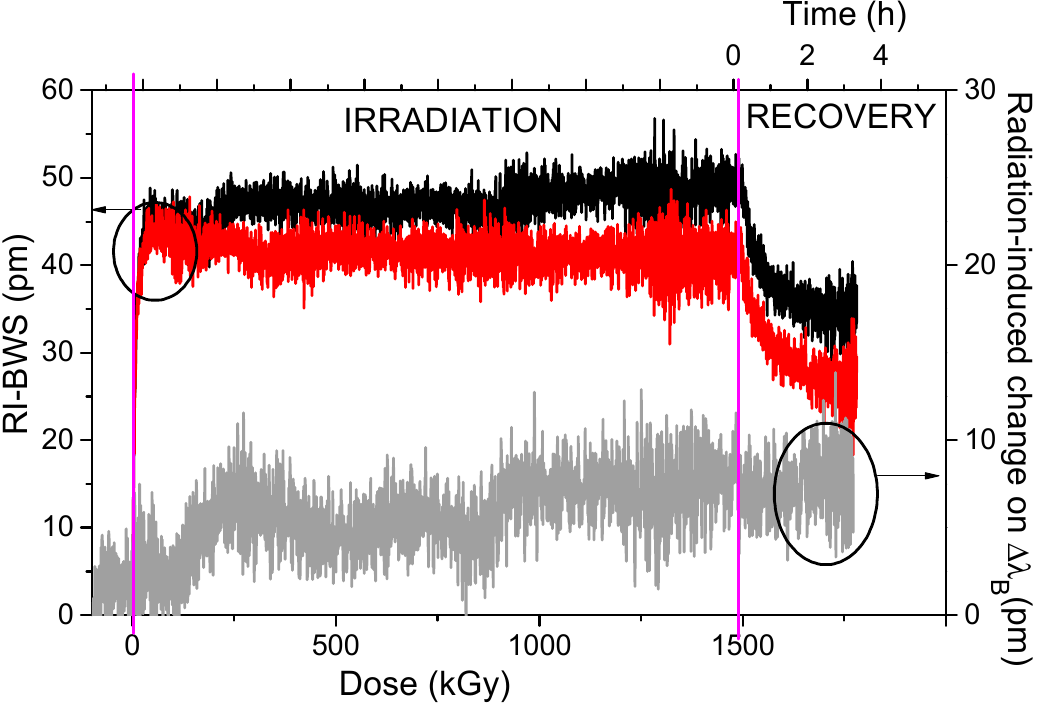
Figure 18. On the left axis, BWS induced by X-rays on the two peaks (peak 1—black points; peak 2—red points) of a grating written with an fs laser (at 267 nm and a pulse width of 120 fs) inside a butterfly PCF with a Ge-doped core, at RT up to 1.5 MGy TID, with a dose rate of 24 Gy/s. On the right axis, changes are induced by the radiation on the spectral distance between the two Bragg peaks. The two pink vertical lines indicate the start and stop of the irradiation run. Data extracted from [73].